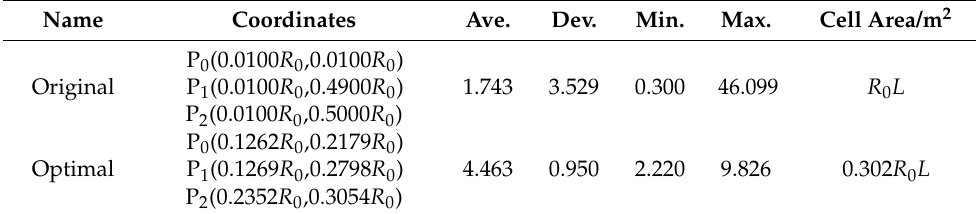
Table 3. Parameters before and after